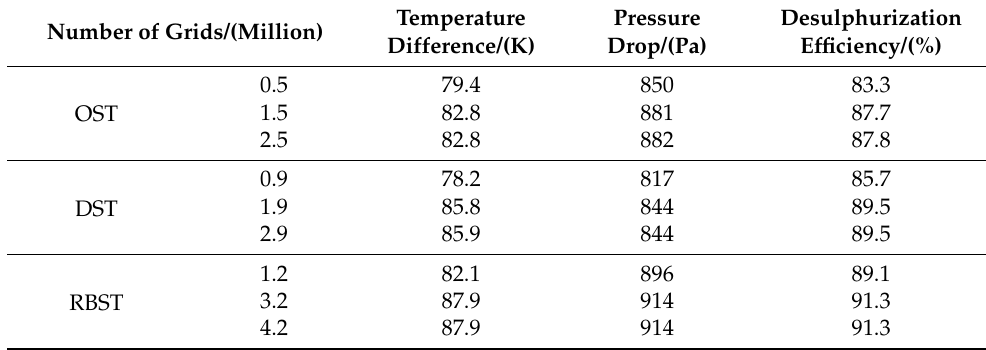
Table 2. Simulation results of different number of grids.